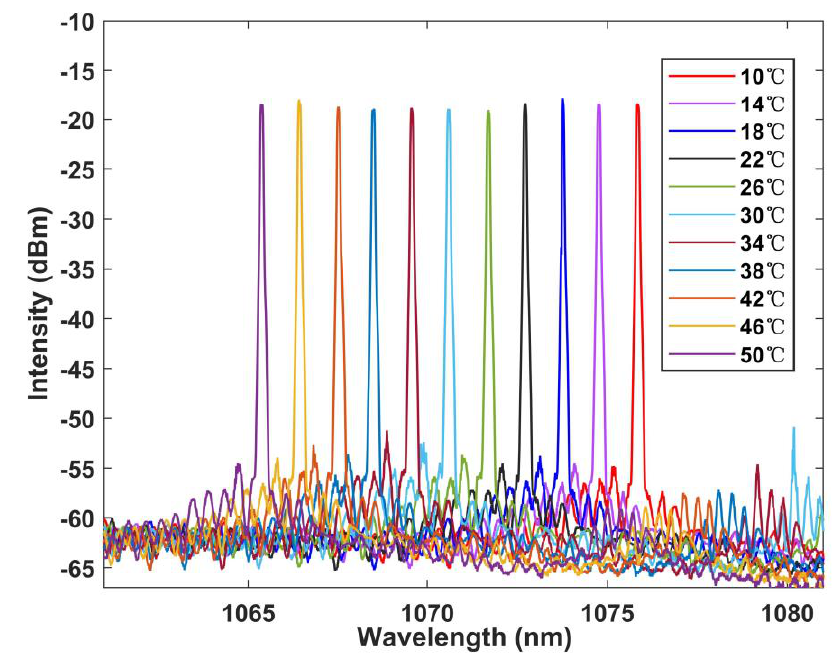
Figure 9. Wavelength versus temperature curve at FRL.